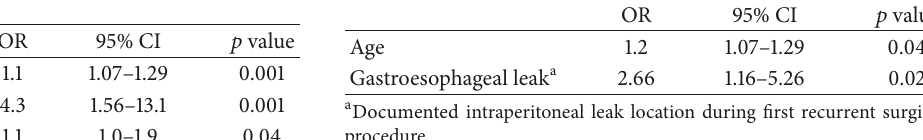
Table 4: Multivariate logistic regression analysis of risk factors for postoperative secondary peritonitis after oncologic upper GIT surgery.